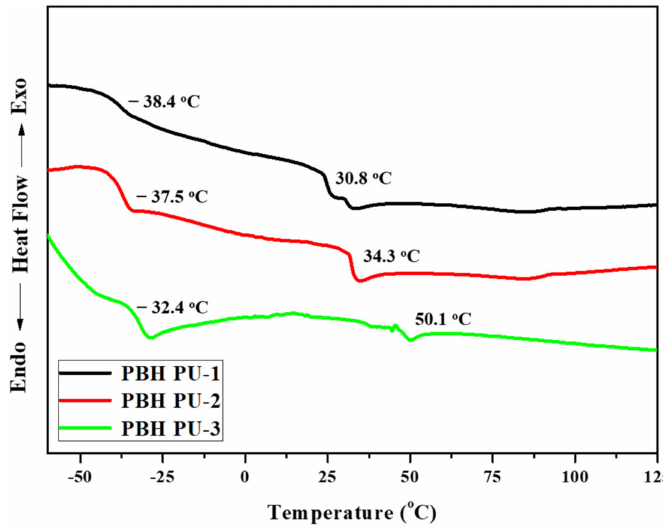
Figure 6. DSC thermograms of polyurethane